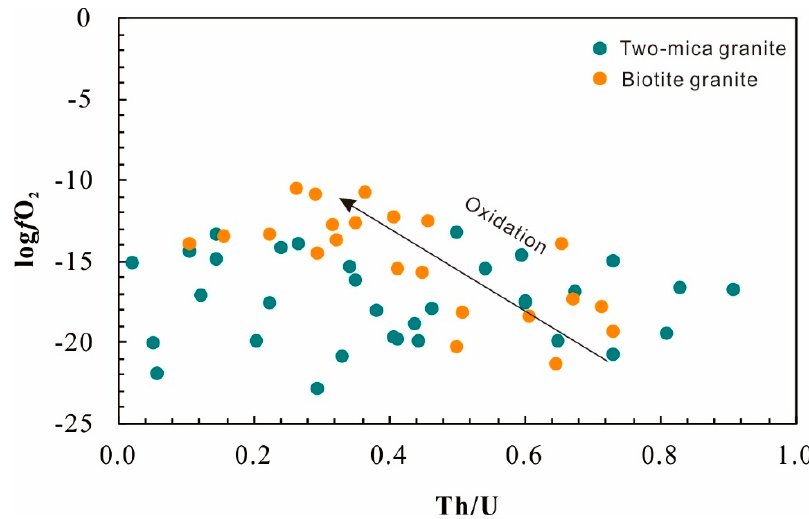
Figure 9. Oxygen fugacity variation during magma evolution (Th/U) reflected by the composition of zircon from the Nashwaak Granite.